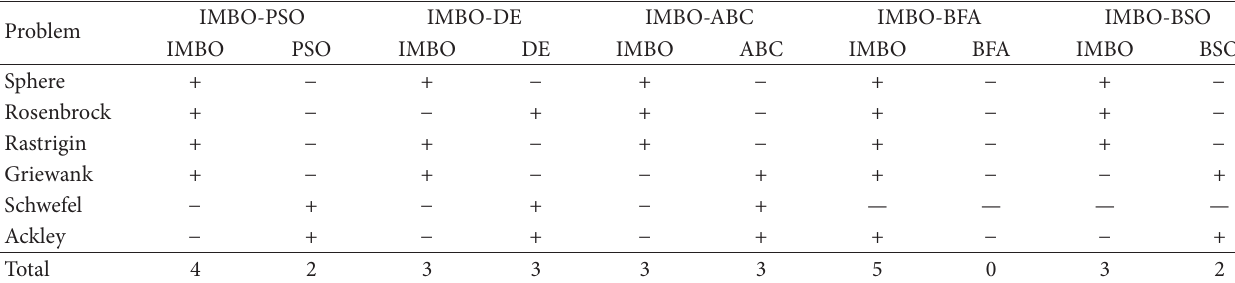
Table 8: Comparative results of IMBO with PSO, DE, ABC, BFA, and BSO algorithms over 30 independent runs for genotype size 50. + indicates that the algorithm is better while − indicates that it is worse than the other, (—): not available value. If both algorithms show similar performance, they are both +.